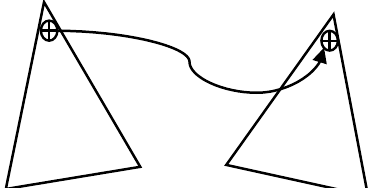
Figure 3. A transformation example between two corresponding triangles: a point in the left triangle is locally transformed to its corresponding position on the right